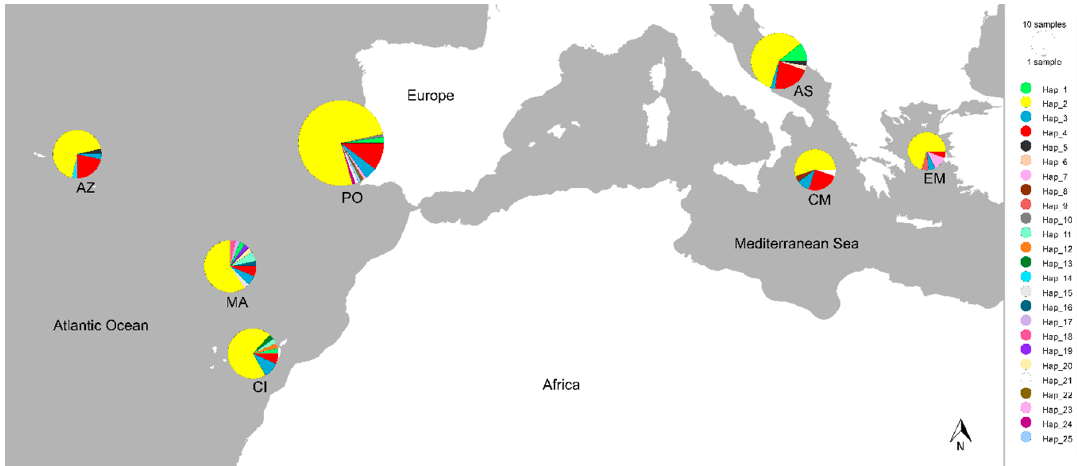
Figure 4. Sampling localities of sequenced blue jack mackerels Trachurus picturatus were placed on a map using PopART and they were named in the same manner as on the IntNJ network